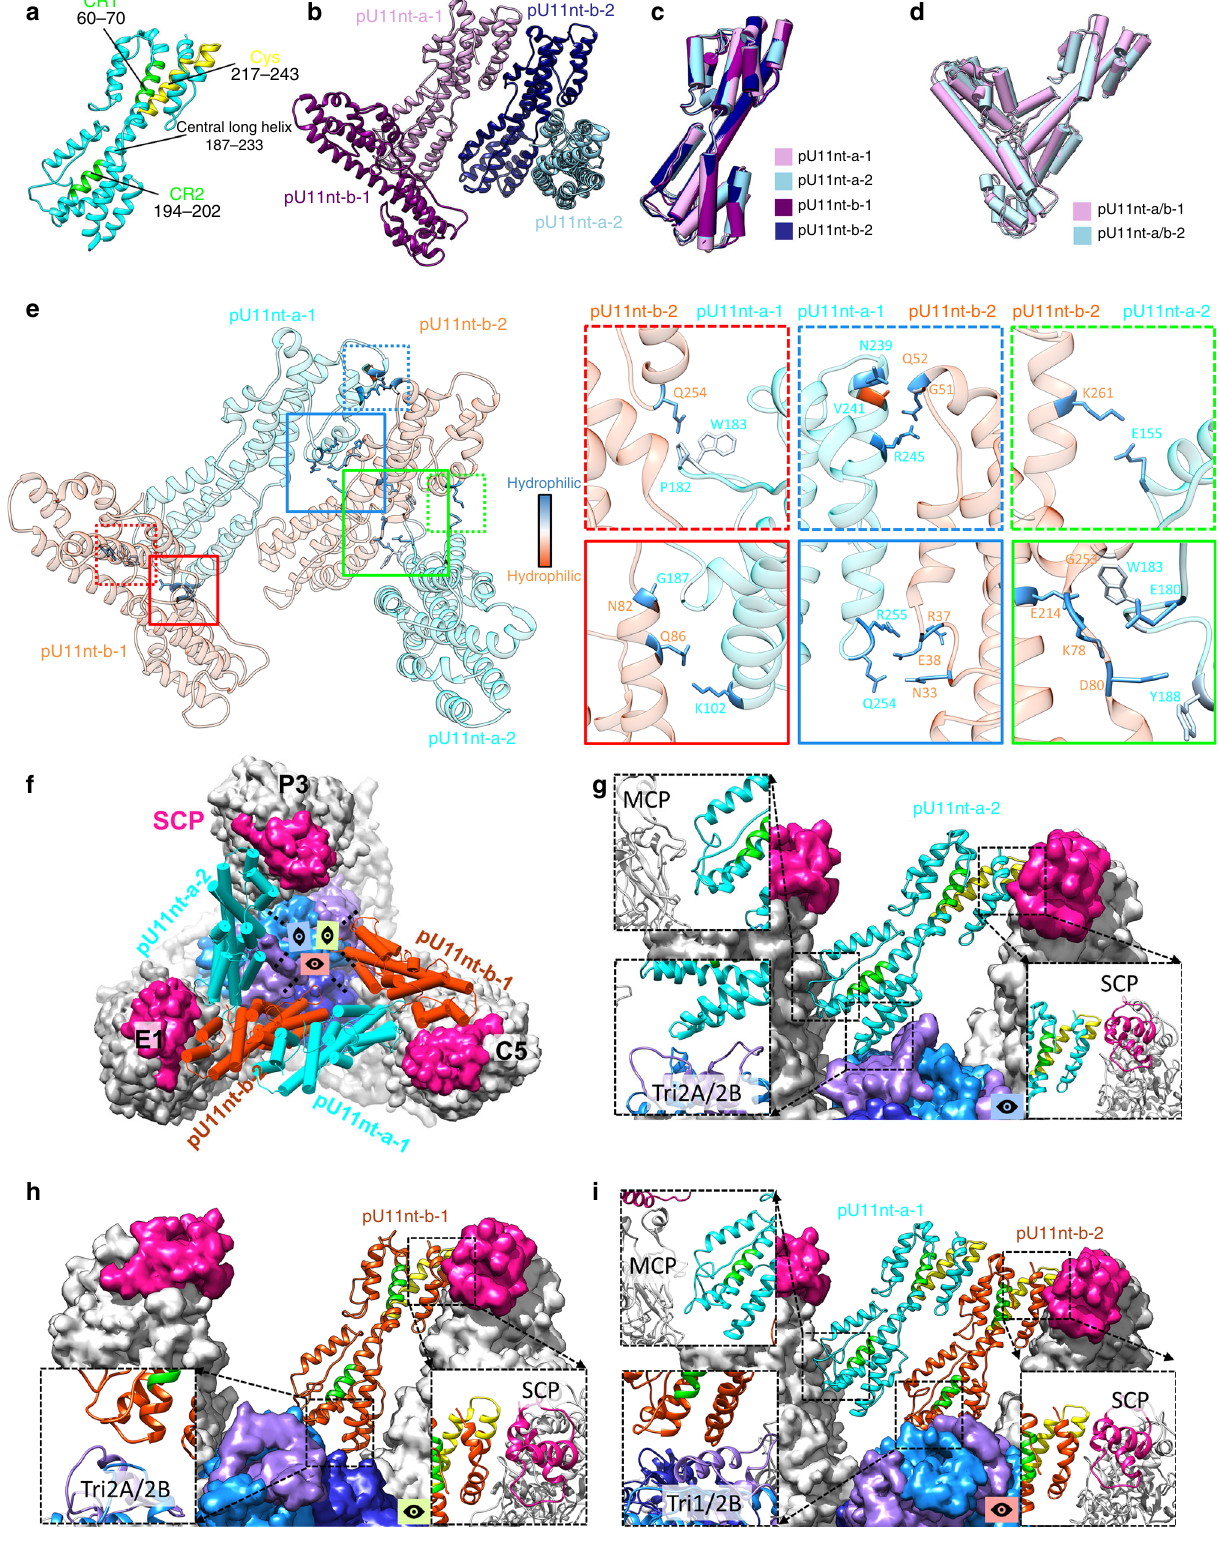
these interactions. First, the upper domain of pU11nt interacts pU11nt (Fig. 4i). Second, the lower domain of pU11nt-b-1 interacts with Tri2A and Tri2B (Fig. 4h), whereas that of pU11nt- b-2 interacts with Tri1 and Tri2B (Fig. 4i). Third, even though